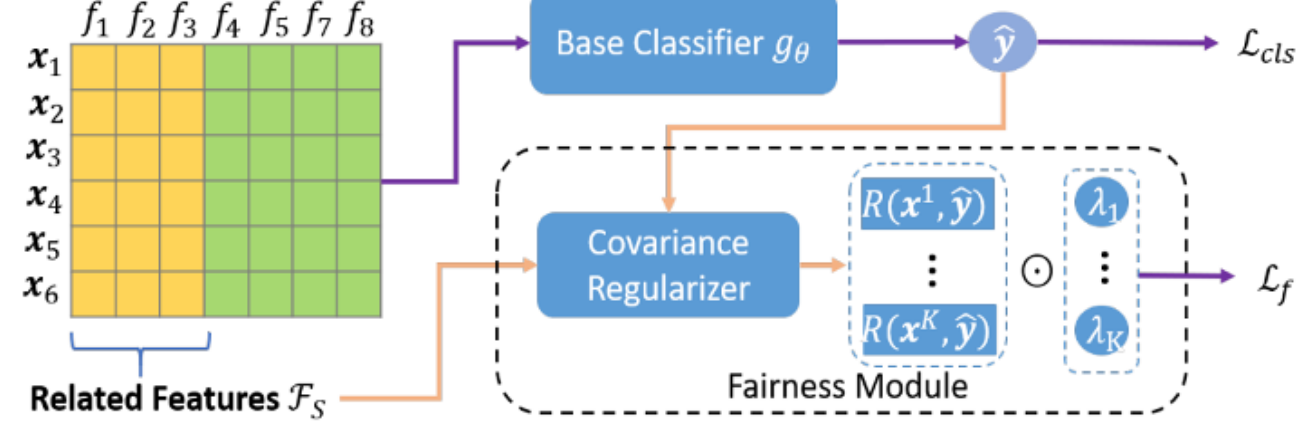
Figure 3. Fair classification with related sensitive attributes